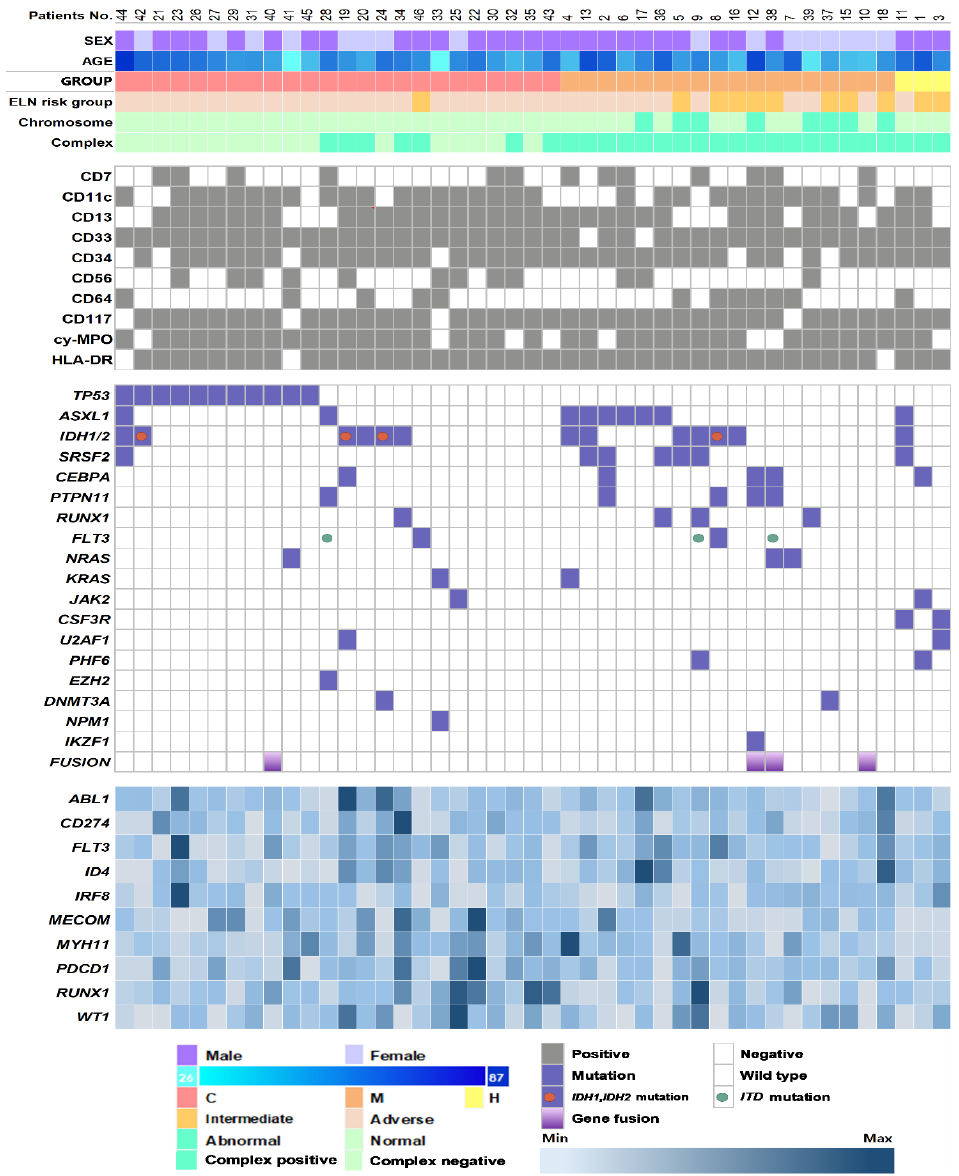
Figure 1. Genetic profile of acute myeloid leukemia with myelodysplasia-related changes (AML- MRC) patients in this study. Data are shown for 45 patients. Each column represents one patient, and each row represents genetic or clinical information. Information on immunophenotypes (gray), mutations (purple), and expressions (blue) is indicated by color and color intensity. Group C: pa- tients with myelodysplastic syndrome (MDS)-defining cytogenetic abnormalities; M: patients with >50% dysplasia in at least two lineages; H: patients with history of prior MDS or MDS/myeloprolif- erative neoplasm; 2017 ELN risk group was the risk category determined following the 2017 Euro- pean LeukemiaNET.